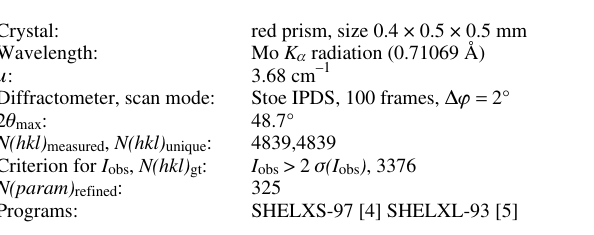
Table 1. Data collection and handling.